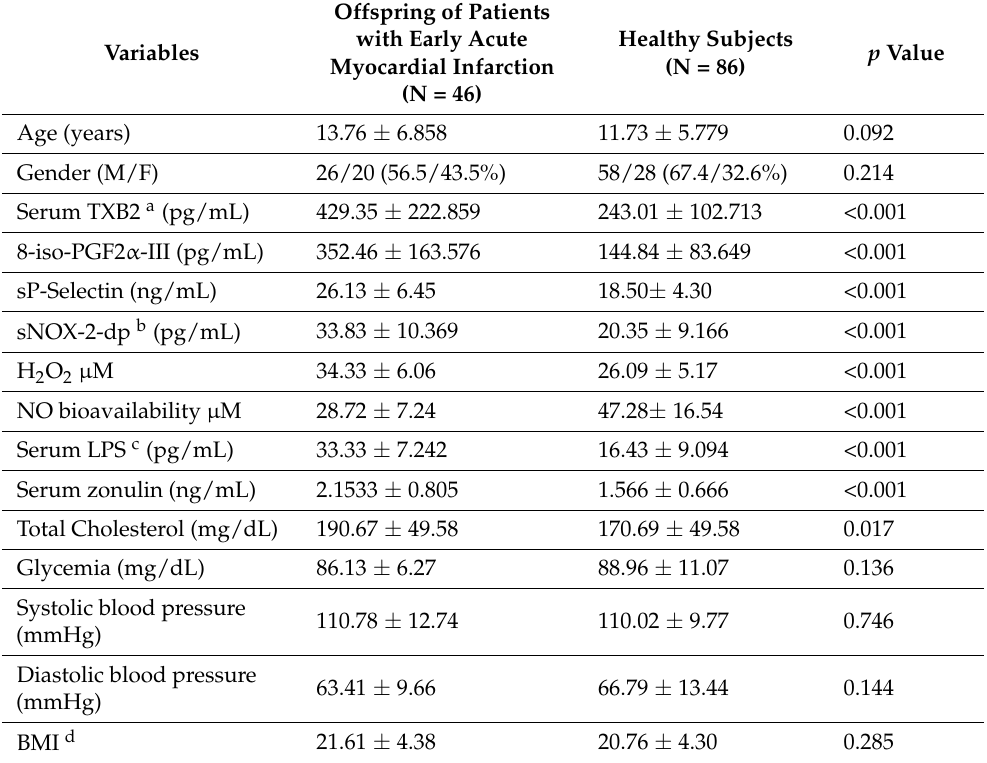
Table 1. Clinical features of offspring of patients with early acute myocardial infarction and HS.